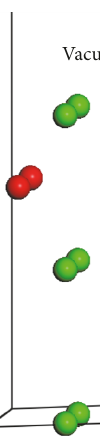
Table 1. All the lattice parameters of the GGA methods (GGA- PBE, GGA-RPBE, and GGA-PW91) are close to the exper- imental values ( 𝑎 = 2.836 ˚A, 𝑏 = 5.867 ˚A, and 𝑐 = 4.955